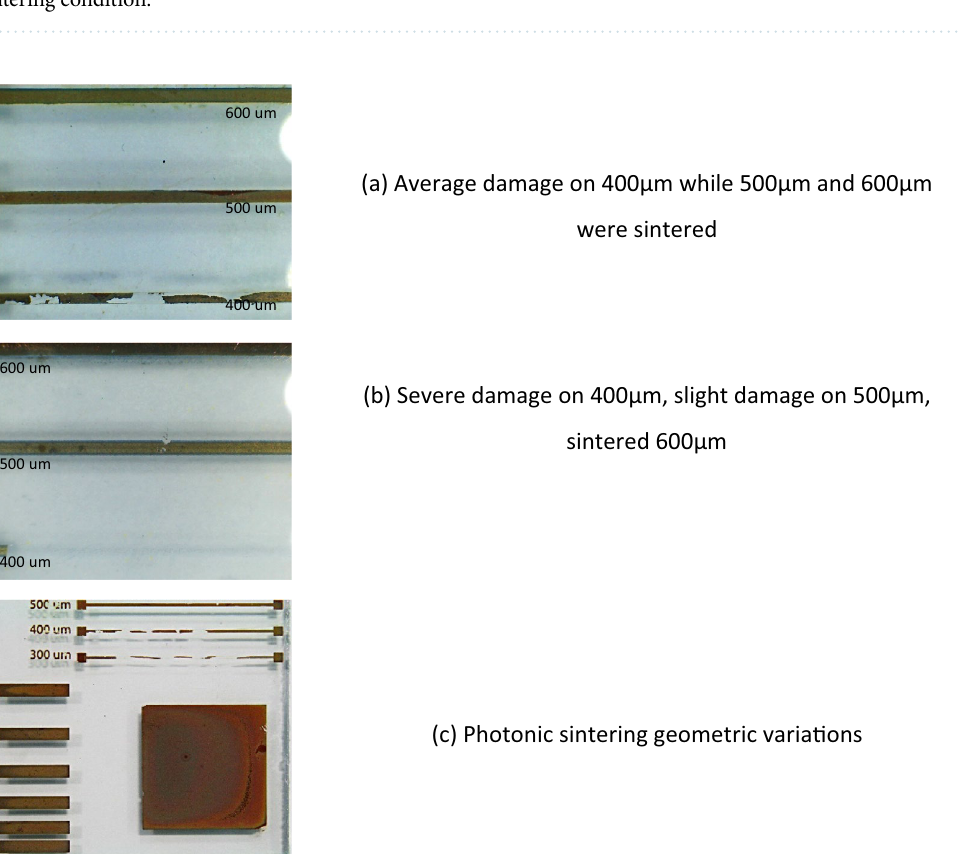
Figure 5. 600 µm Line resistance change over time in weeks for each photonically sintered ink at the optimum sintering condition.